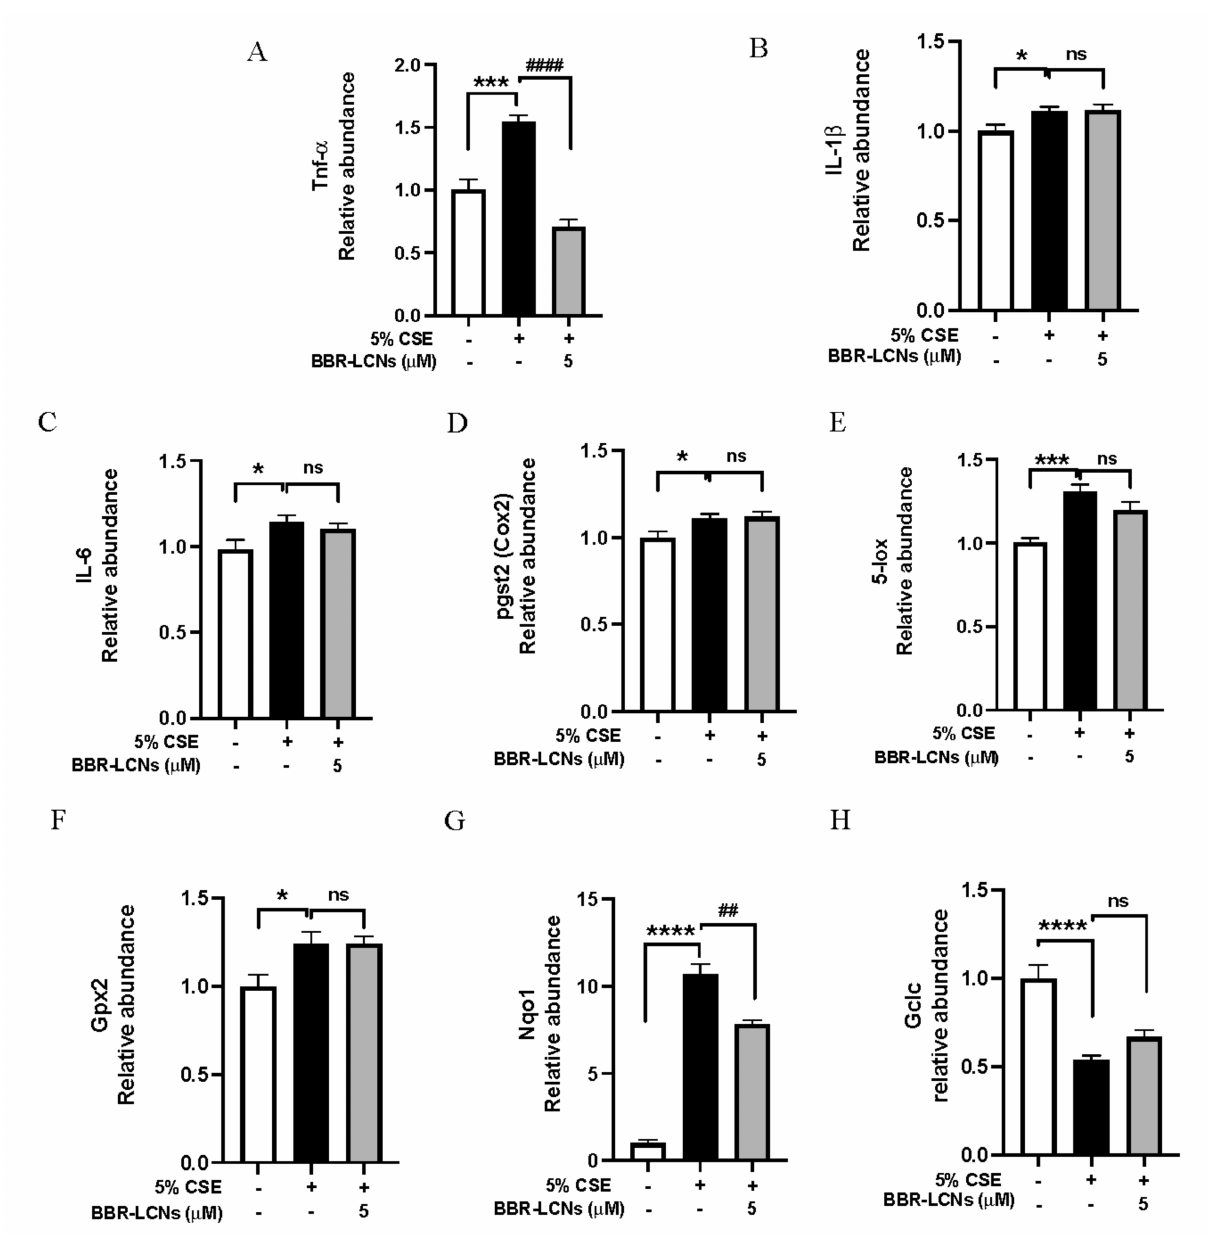
Figure 8. Inhibition of expression of inflammation-related gene ( A ) Tnf- α , ( B ) IL-1 β , ( C ) IL-6 , ( D ) pgst2 ( cox2 ), ( E ) 5-lox , and oxidative-stress-related gene ( F ) Gpx2 , ( G ) Nqo1 , and ( H ) Gclc ex- pression upon treatment with BBR-LCNs on RAW264.7 cells. Values are expressed as mean ± SEM (n = 4); * p < 0.05, *** p < 0.001, **** p < 0.0001 vs. control (without BBR-LCNs treatment) and ## p < 0.01, #### p < 0.0001 vs. 5% CSE only. ns = not significant. Analysis was performed by a one-way ANOVA followed by Tukey multicomparison